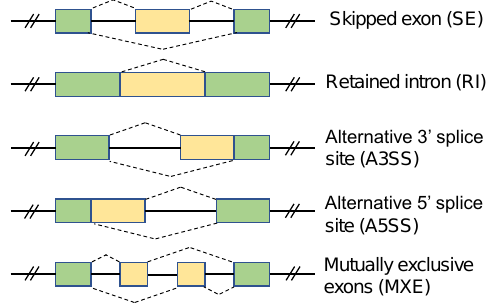
Figure 1. Five major types of alternative splicing events. The alternative splicing exon(s) in each category is highlighted in